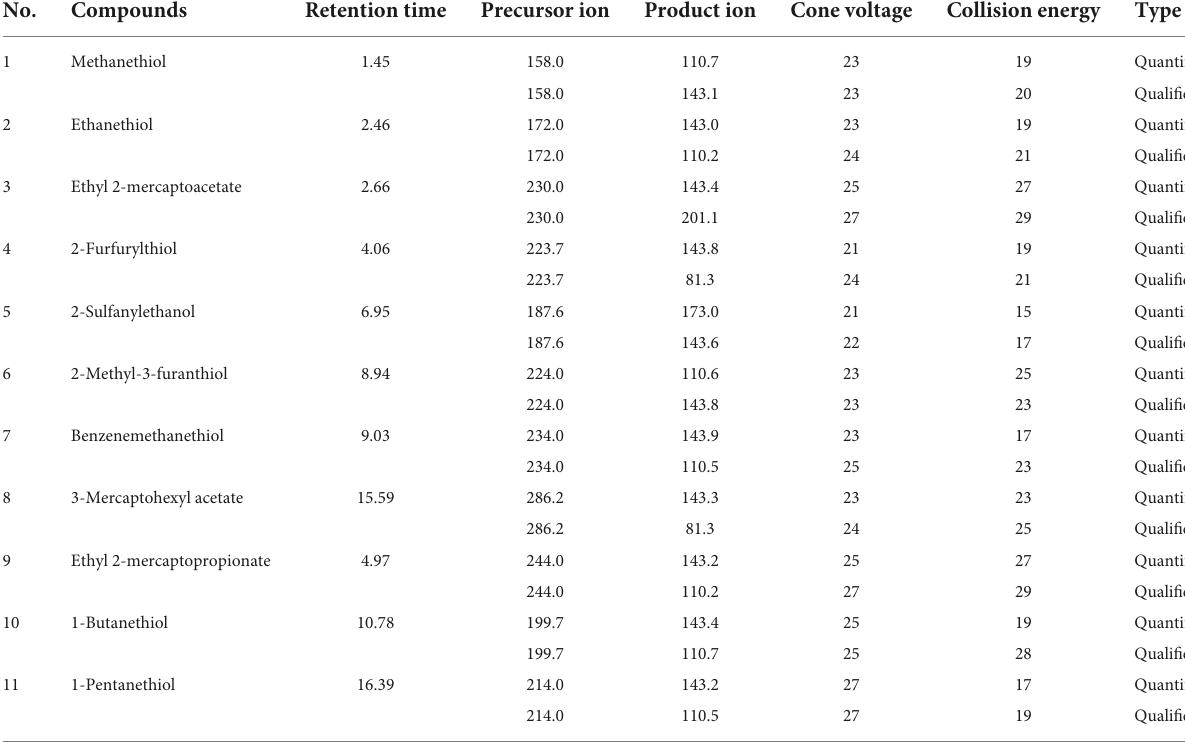
TABLE 1 Optimized multiple-reaction-monitoring (MRM) parameters for the derivatizeds thiol in Baijiu.